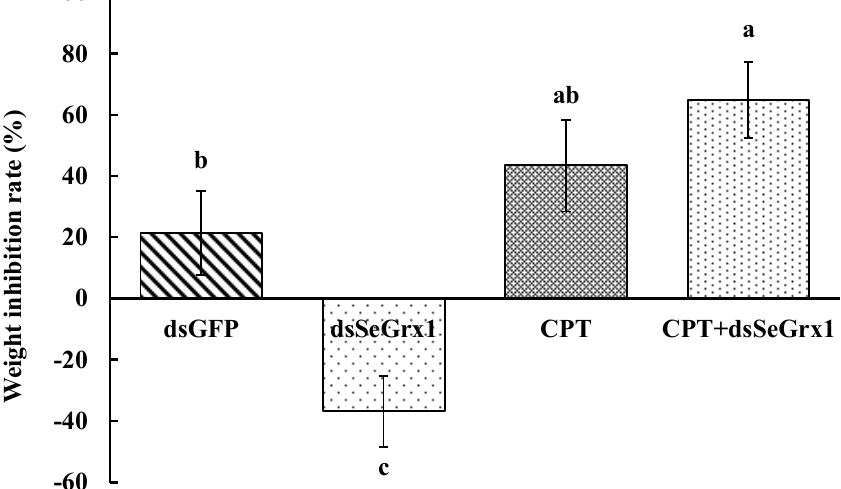
Figure 6. Weight inhibition rate of S. exigua larvae treated by dsRNA and/or CPT at 120 h. Values are shown as mean ± SEM. Data followed by the same lowercase letters indicate no significant difference at 0.05 level.